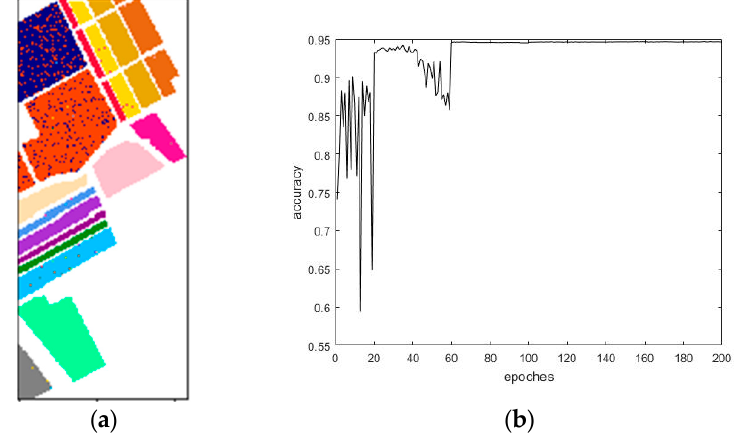
Figure 13. ( a ) Maximum overlapping pooling CNN classification results. ( b ) Maximum overlapping pooling CNN classification accuracy results.